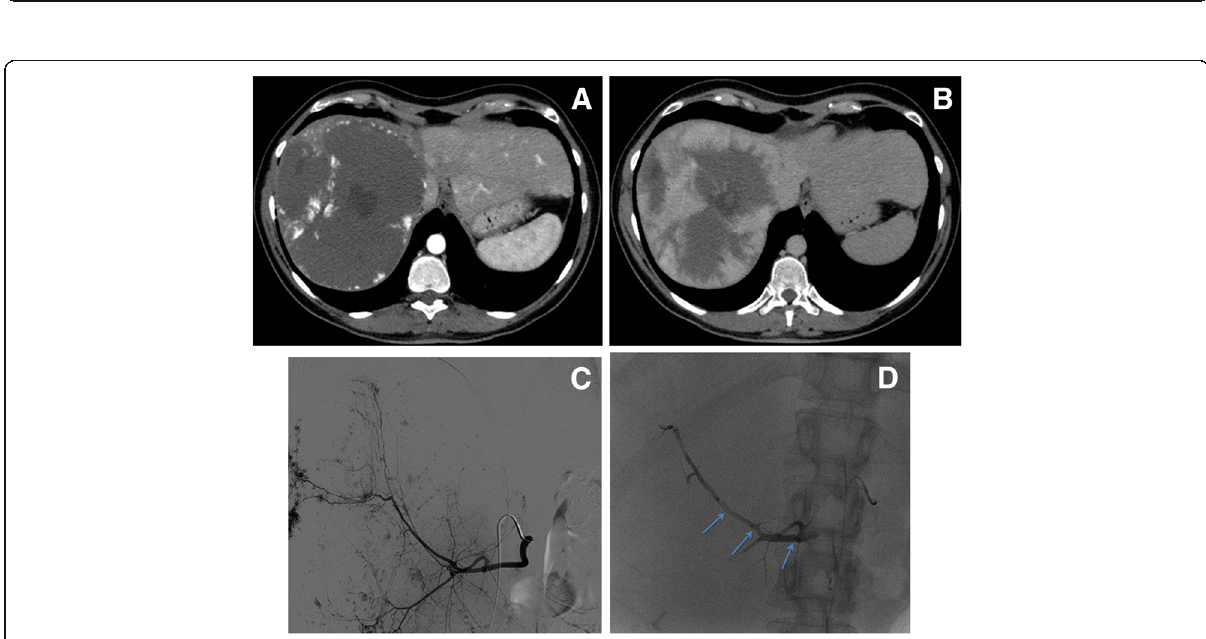
Fig. 6 Preoperative embolization. a Contrast-enhanced CT in arterial phase of a hepatic giant hemangioma. b Contrast-enhanced CT in late phase. c Diagnostic DSA of the hepatic artery. d Final angiographic control after preoperative embolization using PVA particles and Squid (light blue